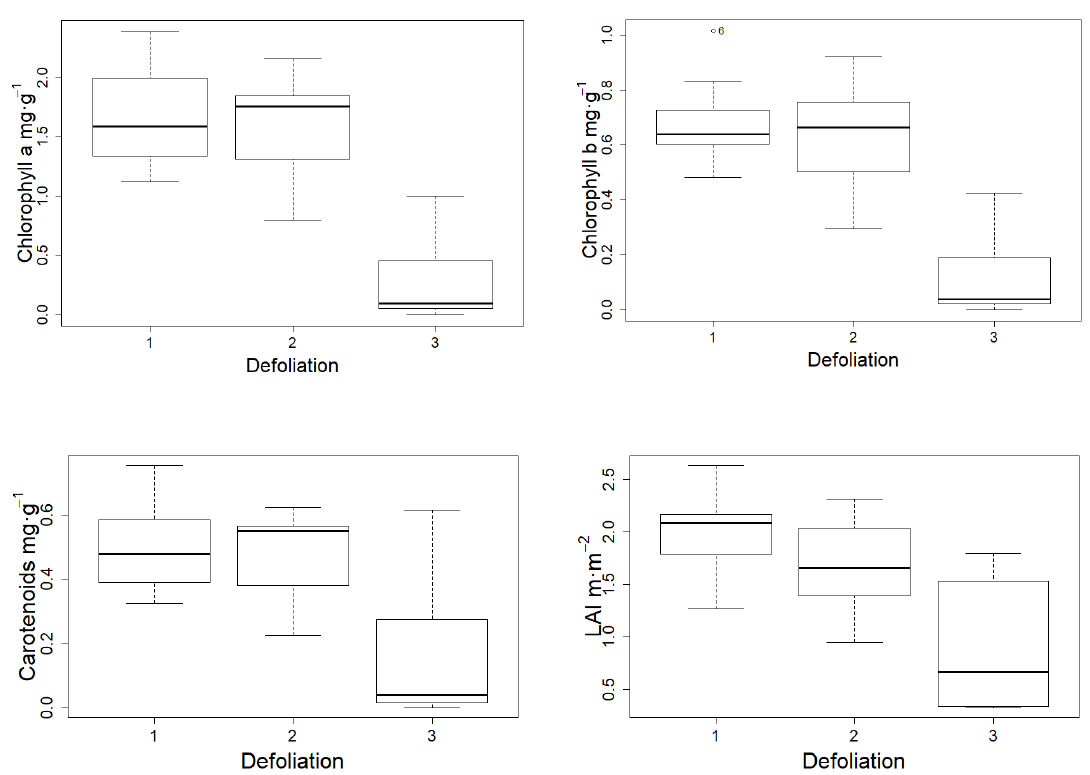
Figure 2. Mean values and standard errors of the LAI and leaf pigments measurements versus crown defoliation in Pinus sylvestris plantations in southern Spain.